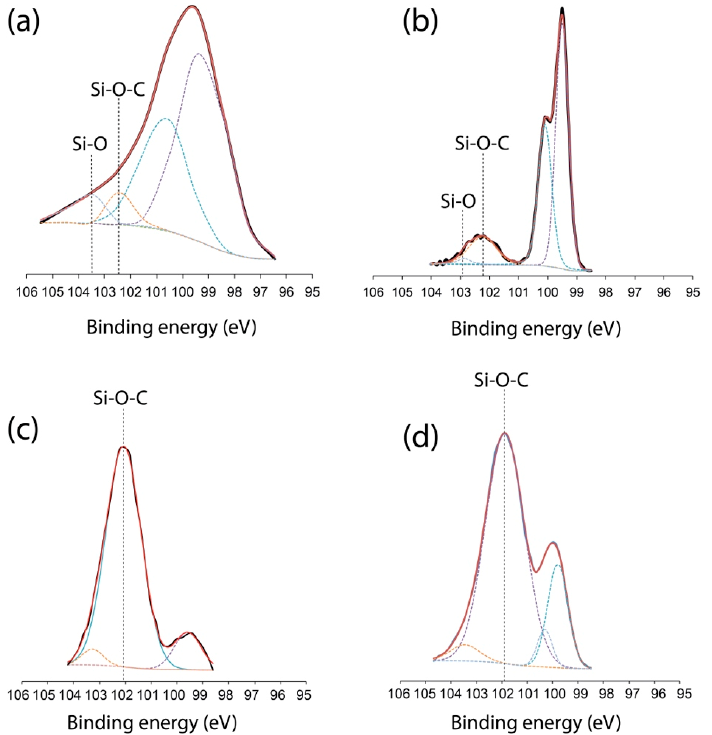
Figure 2. X-ray photoelectron spectroscopy (XPS) Si2p spectrum of ( a ) p -type silicon (111); ( b ) n -type silicon (111); ( c ) p -type silicon (100) and ( d ) n -type silicon (100). Note the emergence of the Si–O–C bond centering at ~102 eV.